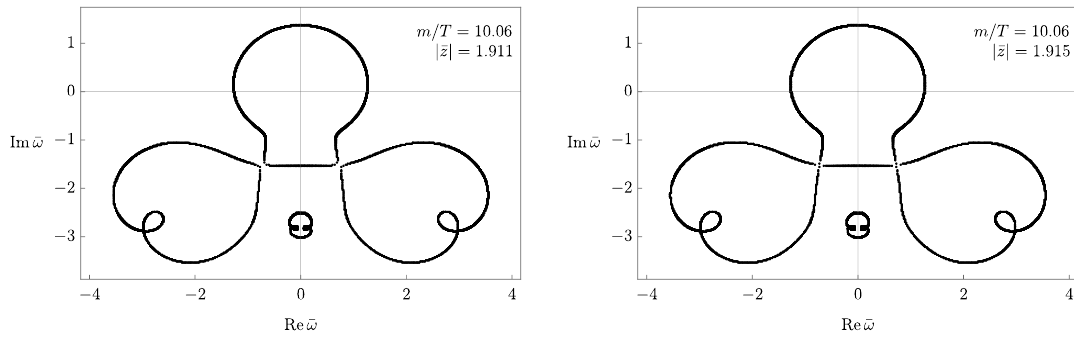
Figure 6 . Plots of ¯ ω (¯ z ) for ¯ z = | ¯ z | e iφ , with φ ∈ [0 , 2 π ] , before and approximately at the leading collision of the pair of transverse sound modes with a pair of gapped modes in the holographic solid model for m/T = 10 . 06 . This collision sets the radius of convergence to ¯ R s = 1 . 92 . Table 2 . Relevant quantities for the analysis of univalence in the longitudinal and the transverse channels of the holographic solid model: convergence radii of the hydrodynamic sound and diffusive series ¯ R s and ¯ R d , the absolute value of the pole-skipping wavevector | ¯ z p | , the absolute value of the wavevector at which the group velocity of the mode vanishes | ¯ z g | , the diffusion constant ¯ D and the speed of sound v s . All quantities (except the already dimensionless v s ) are stated in their dimensionless form, in units of 2 πT . The symbol 7 indicates that the corresponding value is not well-defined, does not exist or that it is irrelevant for the present